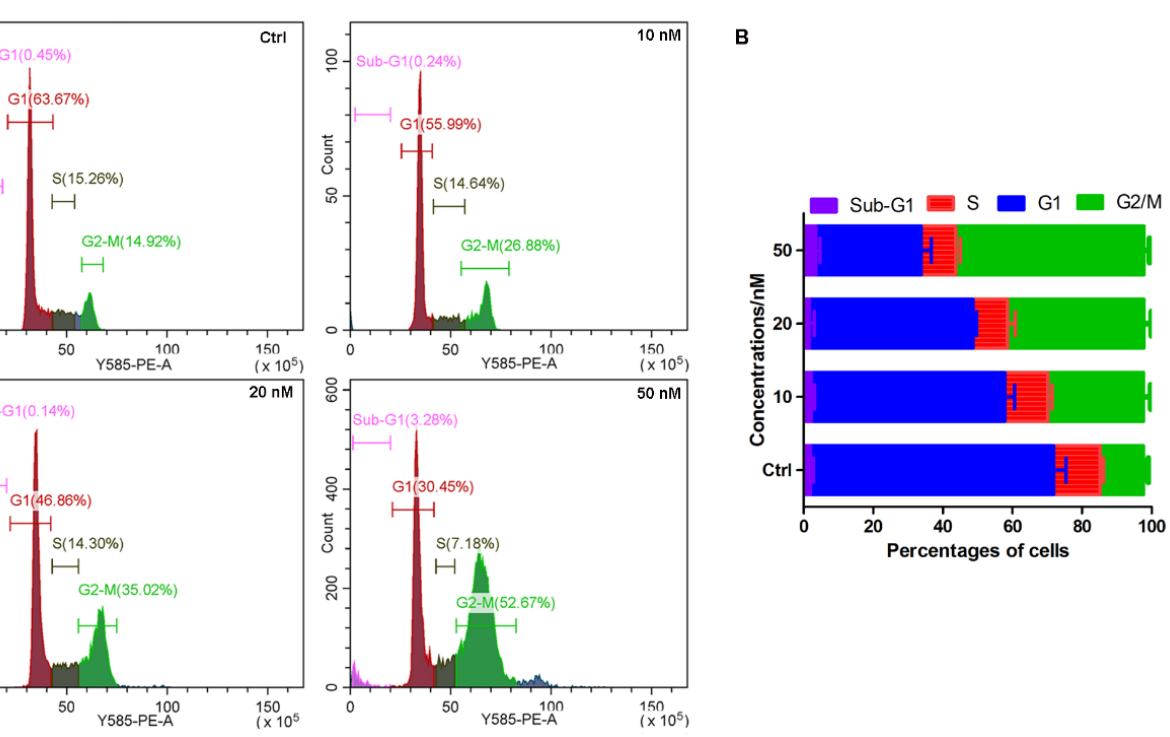
Figure 3. Compound 14b induced cell cycle arrest at the G2/M phase. ( A ) The PI-stained DNA content detected by flow cytometry. A549 cells were treated with or without compound 14b at concentrations of 10, 20 and 50 nM for 24 h; then, the cells were harvested for cell cycle analysis by flow cytometry. ( B ) Quantitative analysis of the percentage of cells in each cell cycle phase by CytExpert analysis software. The experiments were performed at least three times, and the results of the representative experiments are shown. the representative experiments are